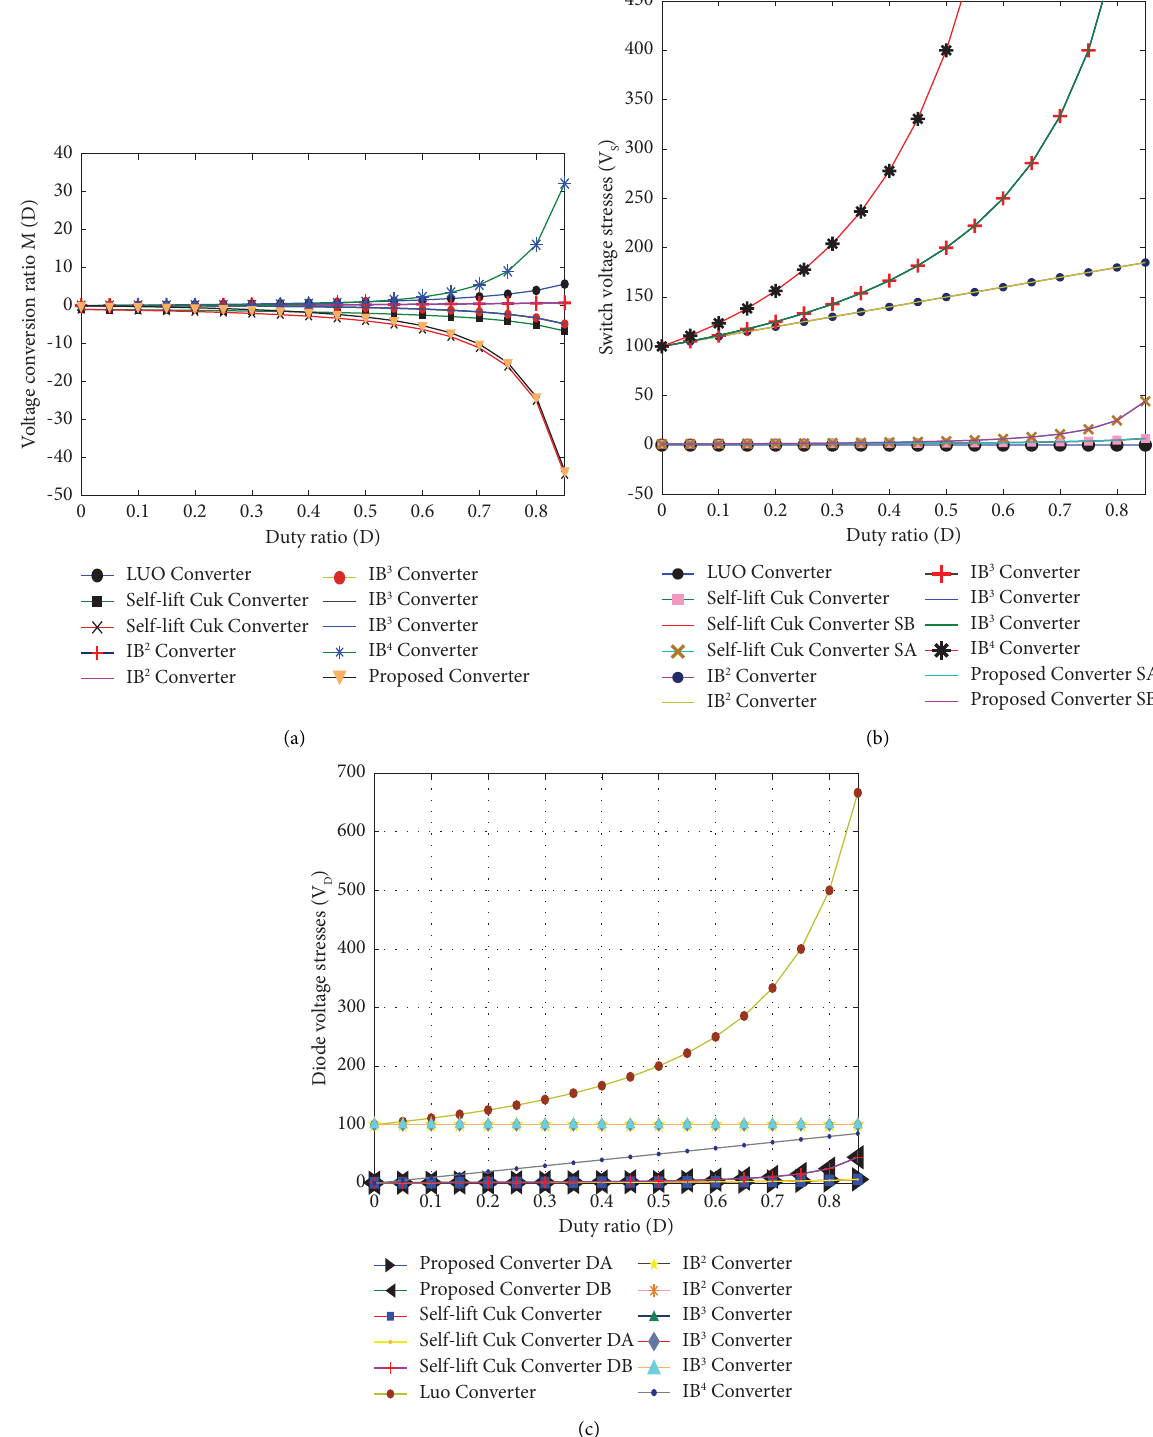
Figure 4: (a) D and M ( D ): voltage conversion ratio M ( D ) values for various duty ratio ( D ). (b) D and V ( D ): switch voltage stresses for various duty ratios. (c) D and V ( D ): diode voltage stresses for various duty